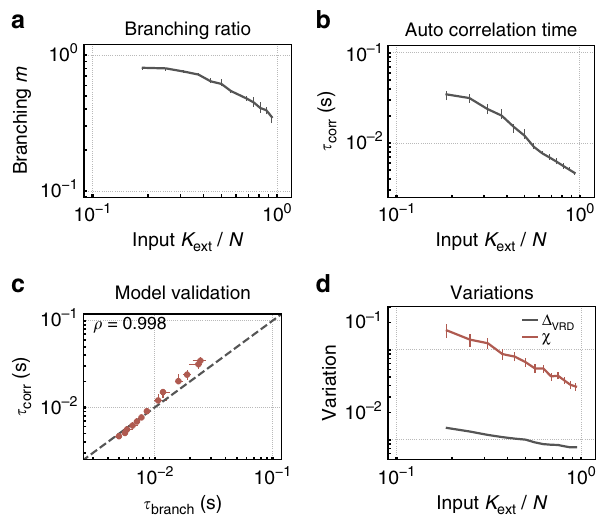
Fig. 4 For low degree of input K ext , the network shows clear signatures of criticality beyond power laws. Only for low values of K ext , a the estimated branching ratio m tends toward unity, and b the estimated autocorrelation time τ corr peaks. c The match of the τ corr , and the τ 1 = log ð m Þ as branch (cid:2) (cid:3) inferred from m supports the criticality hypothesis (correlation coef fi cient of ρ = 0.998, p < 10 − 10 ). d Trial-to-trial Δ VRD variations as well as the susceptibility χ increase for low K ext